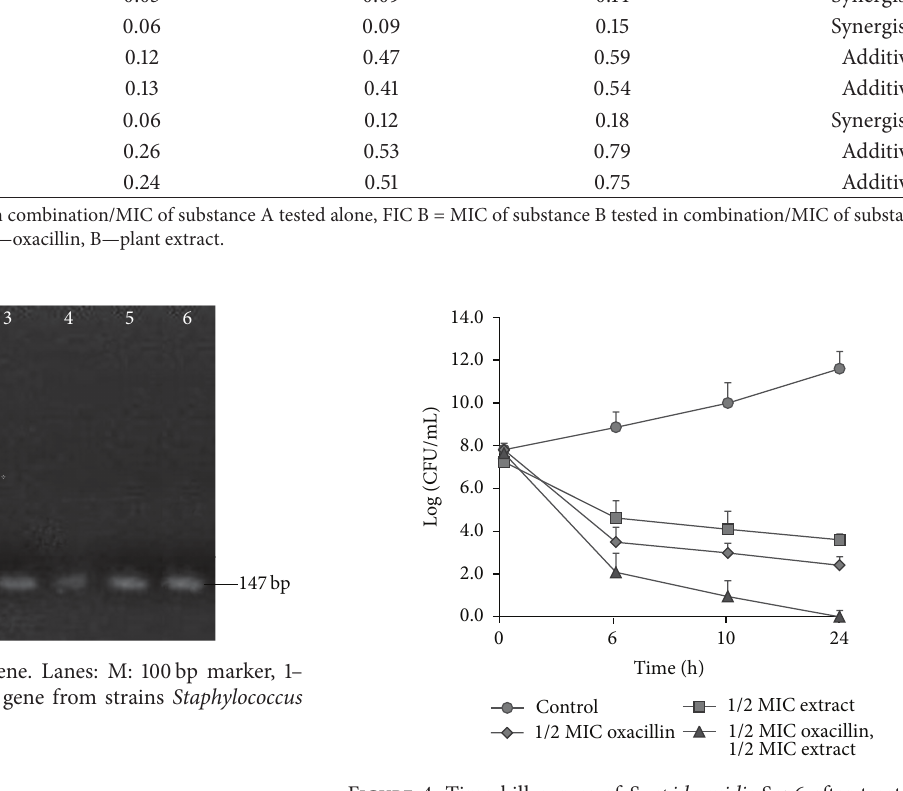
Figure 4: Time-kill curves of S. epidermidis Sep6 after treatment with 1/2MIC of oxacillin, 1/2MIC of extract from Salvia officinalis alone or in